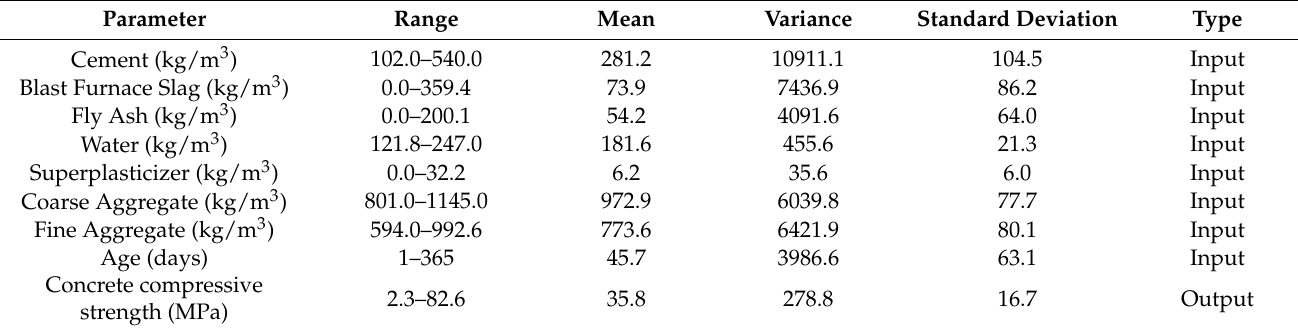
Figure 11. Histogram of nine parameters. Table 5. Numerical characteristics of the parameters.